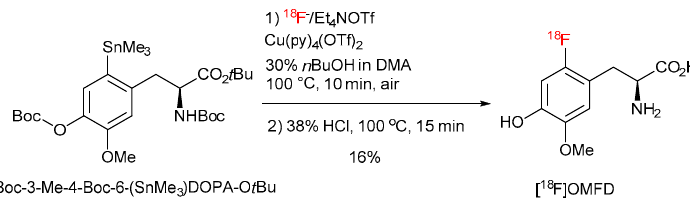
Figure 12. 18 F-Fluorodestannylation of N -monoBOC protected [ 18 F]OMFD precursor.